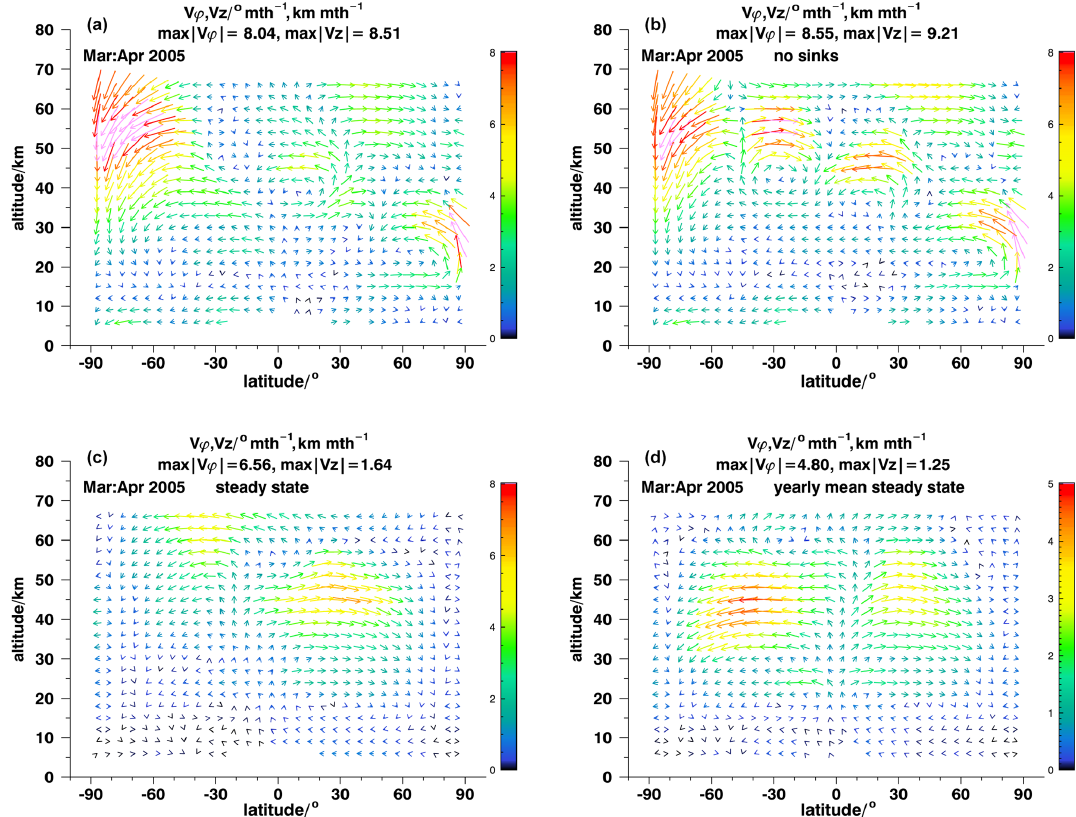
Figure 1. The meridional middle atmospheric circulation as retrieved with ANCISTRUS for March–April 2005 under realistic assump- tions (a) , without consideration of sinks of trace gases (b) , and for sinks perfectly balanced by transport for actual (c) and annual mean (d) (cid:113) (v φ degree − 1 month ) 2 + v z km − 1 month ) 2 for v φ and v z in units of degree per month and kilometer per conditions. The color scales refer to month. Pink arrows refer to velocities higher than representable by the color scale